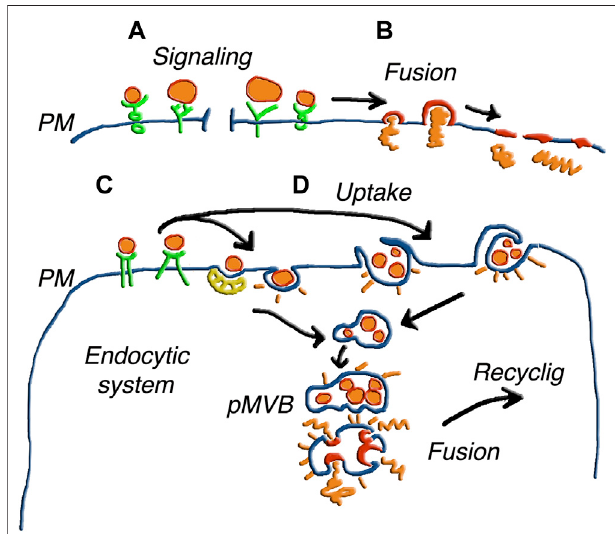
FIGURE3| VariousformsofEVfusionwithtargetcells.Thedifferentsize of the EVs illustrates the parallel processes of ectosomes and exosomes. (A) shows vesicles inducing only signaling upon binding to receptors. In (B) the fusion of single vesicles followed by the integration of the membrane the plasma membrane (PM), induces release of cargo to the cytoplasm. In (C) the EVs,boundtoreceptorssuchasthosein (A) ,areinternalizedinanendosomal cisterna, and the same occurs in (D) for EV groups internalized by phagocytosisor macro-pinocytosis.Uponinternalization,theEVs of (C,D) are accumulated within pseudo multi-vesicular bodies (pMVB). Elimination of these structures by ectosomal block and possible fusion with lysosomes do not appear in this Figure. Alternatively, the EV membranes fuse with endosome membrane and the cargos are released in the depth of the cytoplasm. The possible integration of molecules from fused EVs with molecules generated locally to participate in a new generation of EVs is suggested by the word Recycling. Figure reproduced with permission from Meldolesi